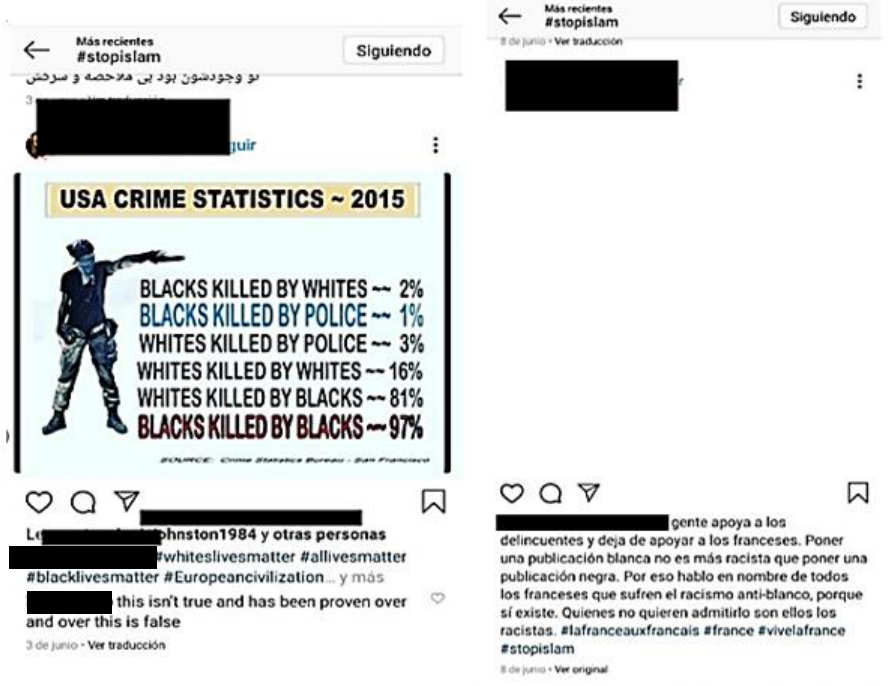
Figure 2. Examples from the category A war between Muslims. Caption: People support criminals and stop supporting the French. Putting a white post is no more racist than putting a black post. That is why I speak on behalf of all French people who suffer from anti-white racism, because it does exist. Those who don't want to admit it are the racists.